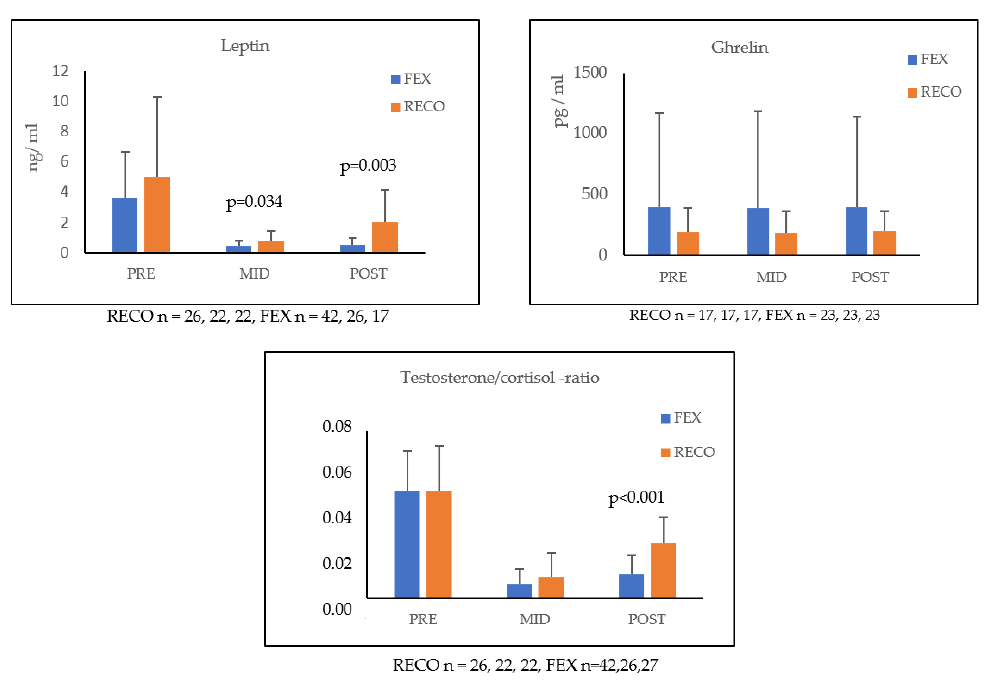
Figure 2. Mean (±SD) leptin, ghrelin, and testosterone/cortisol ratio concentrations during the training in the recovery (RECO) and field exercise (FEX) groups. Statistical significances are presented between the groups.